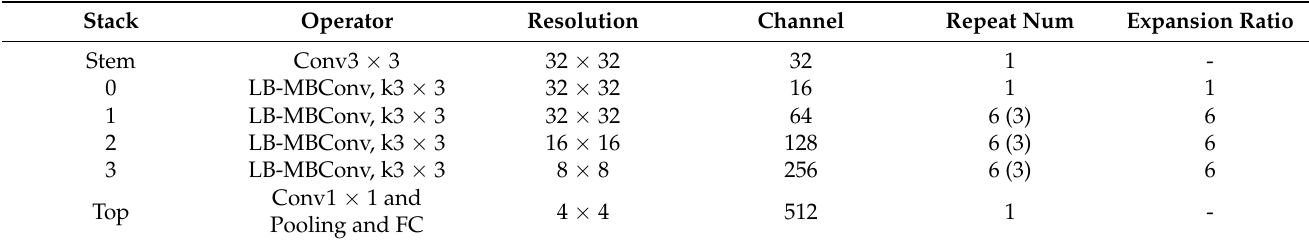
Table 1. Proposed baseline LB-MBNet-59 model structure and input resolution and output channel number of each stack. The repeat numbers in symbols are the parameters of the LB-MBNet-32 model.